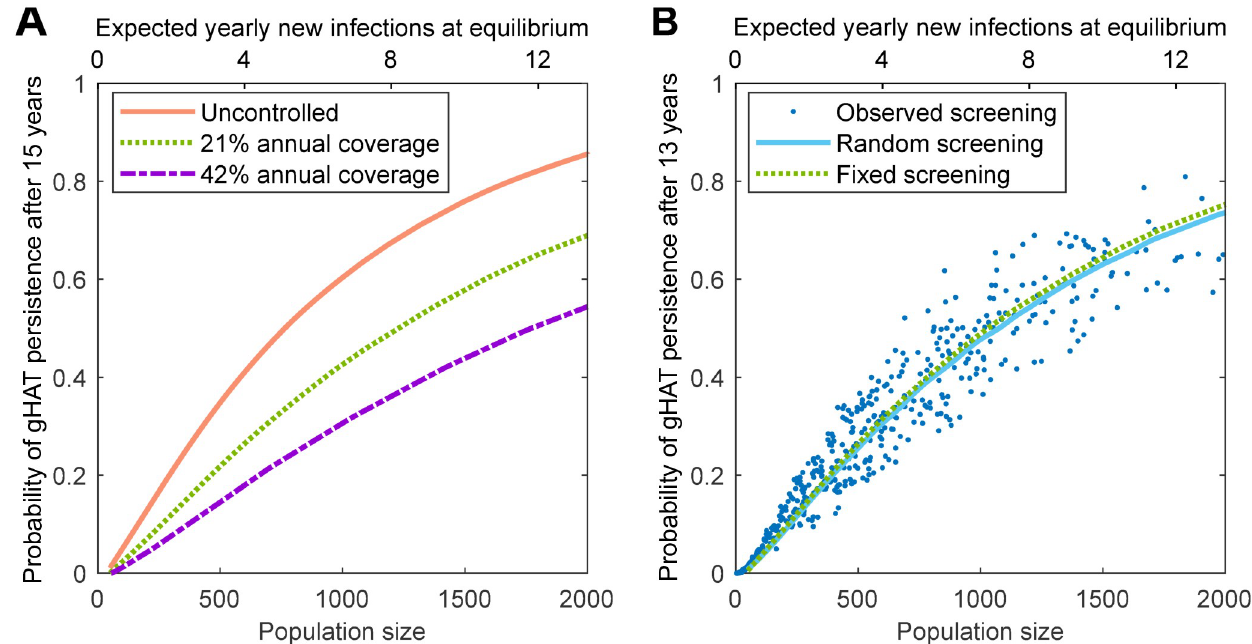
Fig 3. Predicted probability of gHAT persistence in isolated settlements. Simulations are started at the endemic (uncontrolled) equilibrium and iterated forwards (without infectious imports), while the persistence of infection is recorded. This is repeated 100,000 times for settlement population sizes between 50 and 2,000 individuals. The expected number of yearly new infections if the system were at equilibrium is proportional to the population size and is given by the top scale. (A) Impact of active screening on gHAT persistence; annual screening at a fixed coverage per year yields a drop in persistence with increased coverage. (B) Comparison of screening assumptions on the persistence of gHAT. The solid curve shows results where annual screening coverages were randomly sampled from all observed coverages; dots represent the individual settlements recorded in the WHO HAT Atlas for Yasa-Bonga and Mosango health zones [7, 13], where the reported coverage in each year is used. There were sufficient simulations such that confidence intervals are too small to be visible.